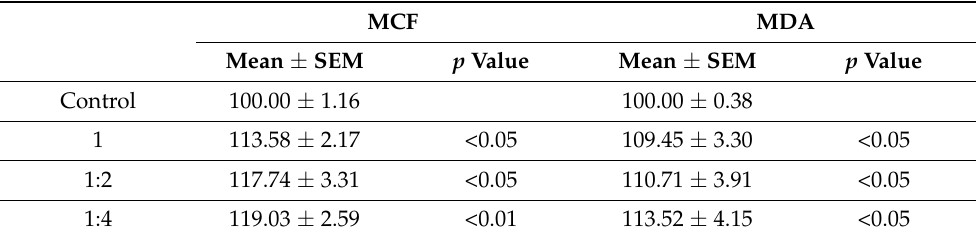
Table 2. Data table regarding the viability of the MCF-7 and MDA-MB-231 cell lines as determined by MTT assay after 48 h of incubation with the tested extract in different dilutions (1; 1:2;